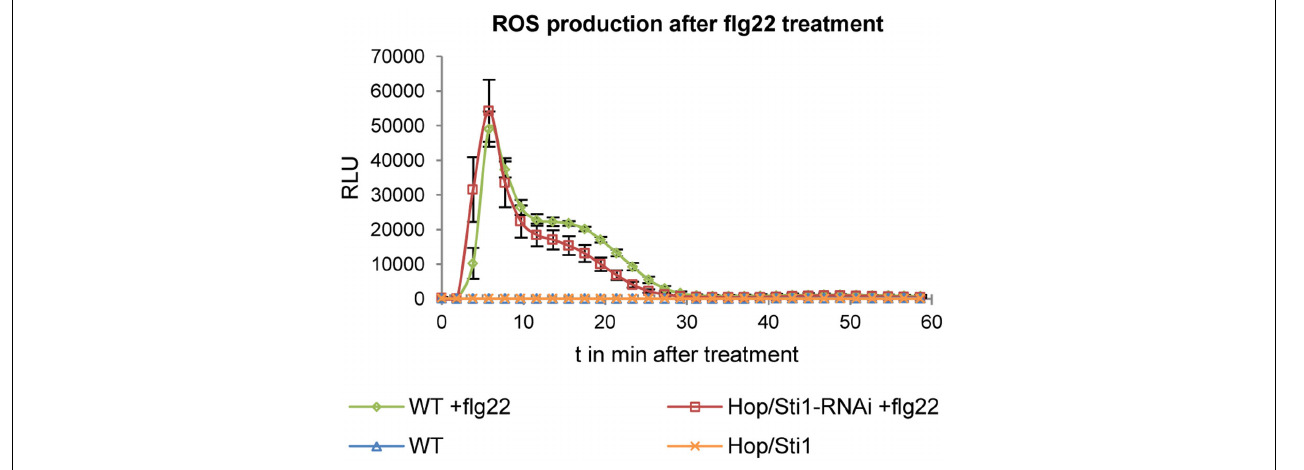
FIGURE 5 | Detection of ROS production in response to flg22 treatment in wild-type plants and in Hop/Sti1-RNAi line #61. Luminescence is given in relative luminescence units (RLU), error bars represent the standard error.